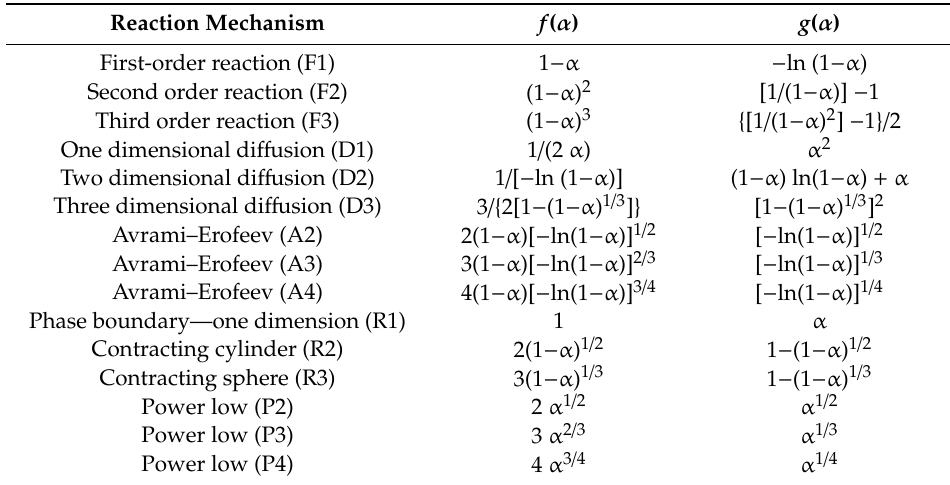
Table 3. Common solid-state thermal reaction mechanisms.